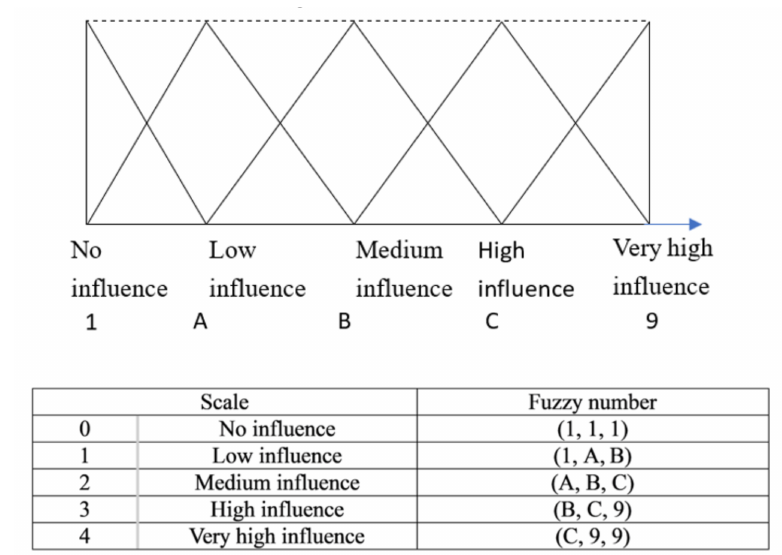
Figure 8. Fuzzy DEMATEL triangular fuzzy